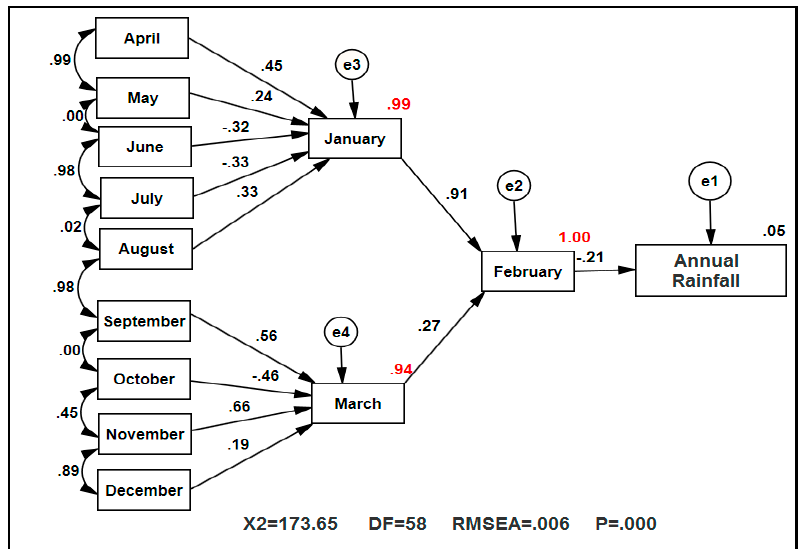
Figure 14. The effectiveness between the monthly temperature and annual rainfall (second model). Monthly effectiveness investigated on annual rainfall series. The effectiveness model shows that nine monthly temperature series (January, March, April, May, June, July, August, September, October, November and December) have indirect effects on annual rainfall. February temperature has a direct effect (negative effect) on annual rainfall. According to Figure 14, there is significant (0.94 < R 2 < 1) effectiveness (red data) between the temperature series and annual rainfall in Iran.